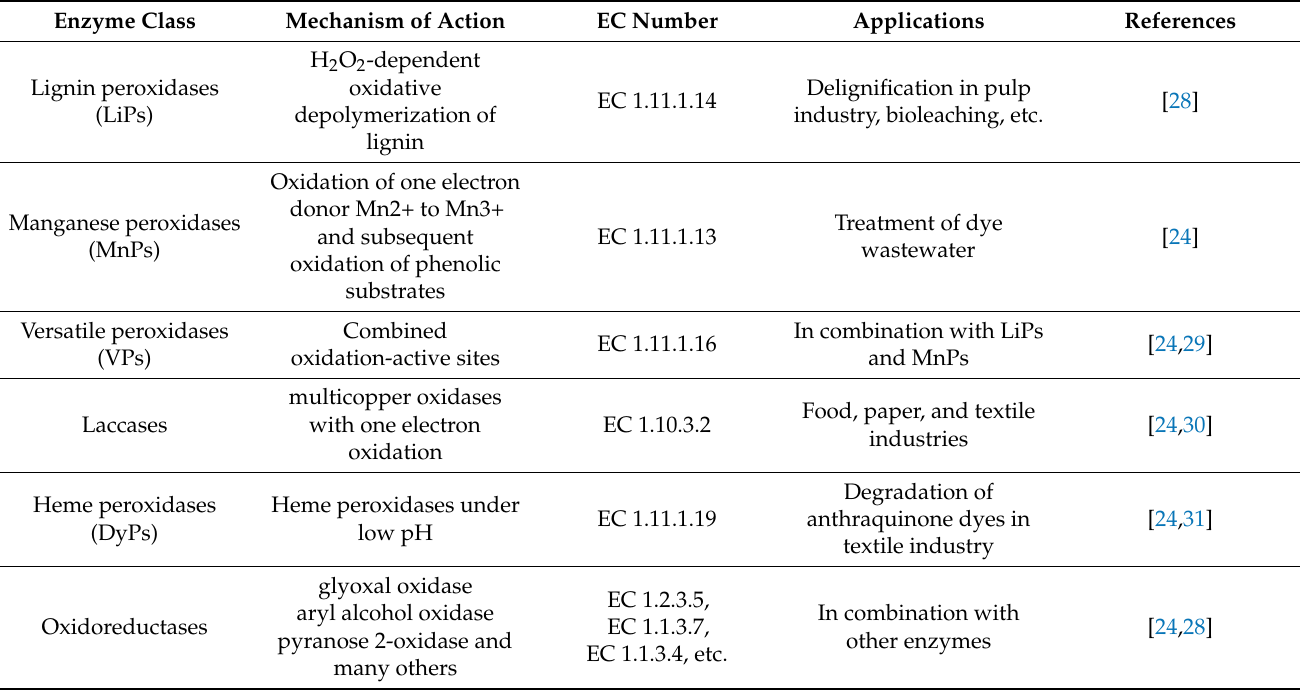
Figure 2. Different enzymatic pathways of microbial lignin degradation [27]. Copyright 2021 by Elsevier. Table 1. Lignin-modifying enzymes (LMEs) and their applications.